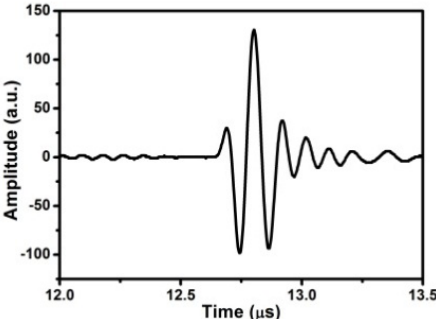
of the target point (0, 30 nm). 12